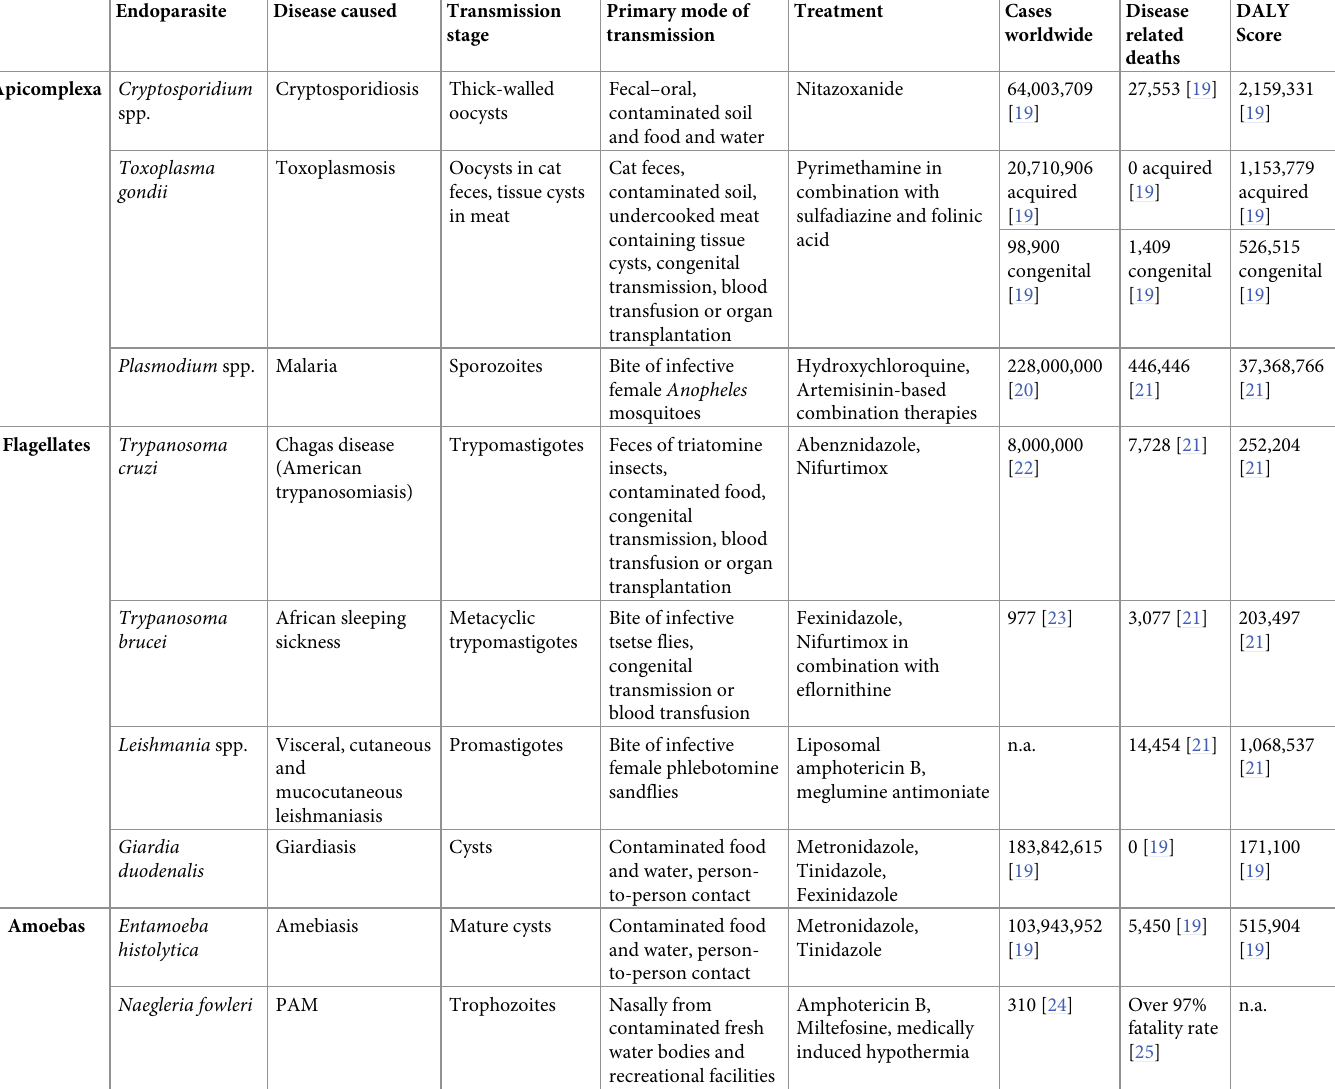
Table 1. List of AU : PleasecheckandconfirmifTable 1 ispresentedcorrectly : protozoans and the associated diseases for which in vitro models are published.